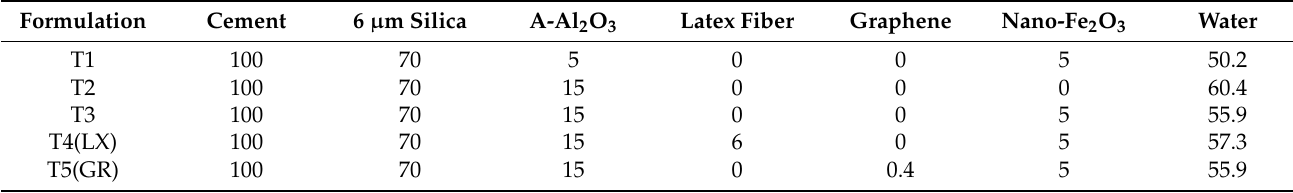
Table 1. Formulation design of cement slurries